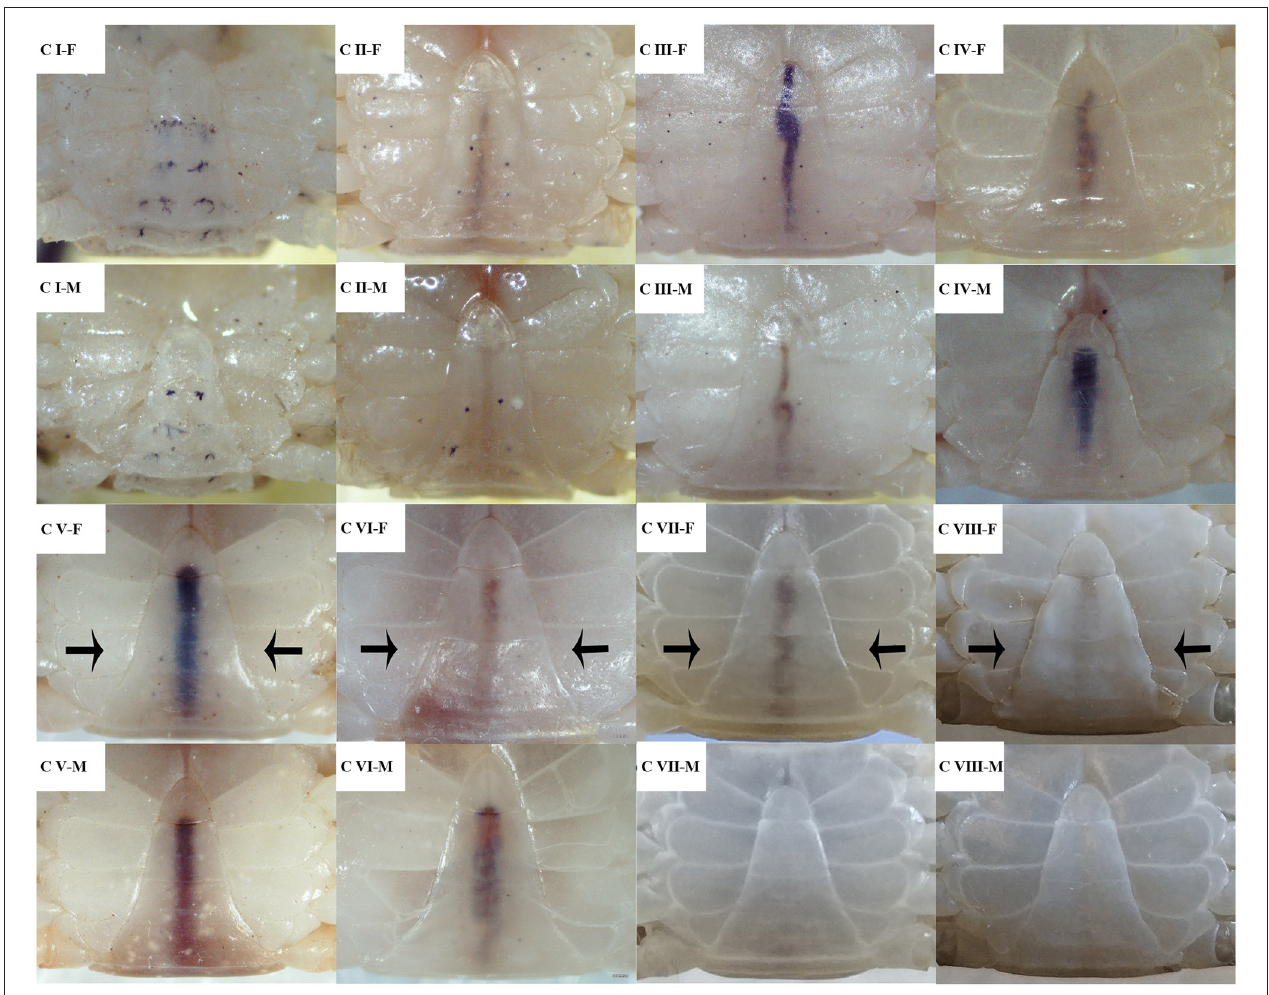
FIGURE 4 | The external morphology of the abdomen at different development stages of male and female S . paramamosain crablets. F, female; M, male. The black arrows represent the segment where the shape was